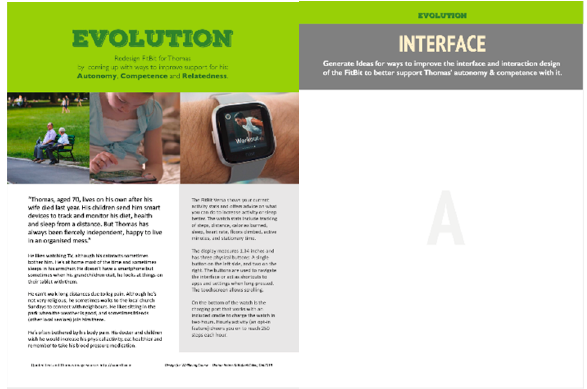
Figure 1. Example materials developed for the prototype workshop. To the ( left ) is a persona and technology overview and to the ( right ) is a blank template for ideas.